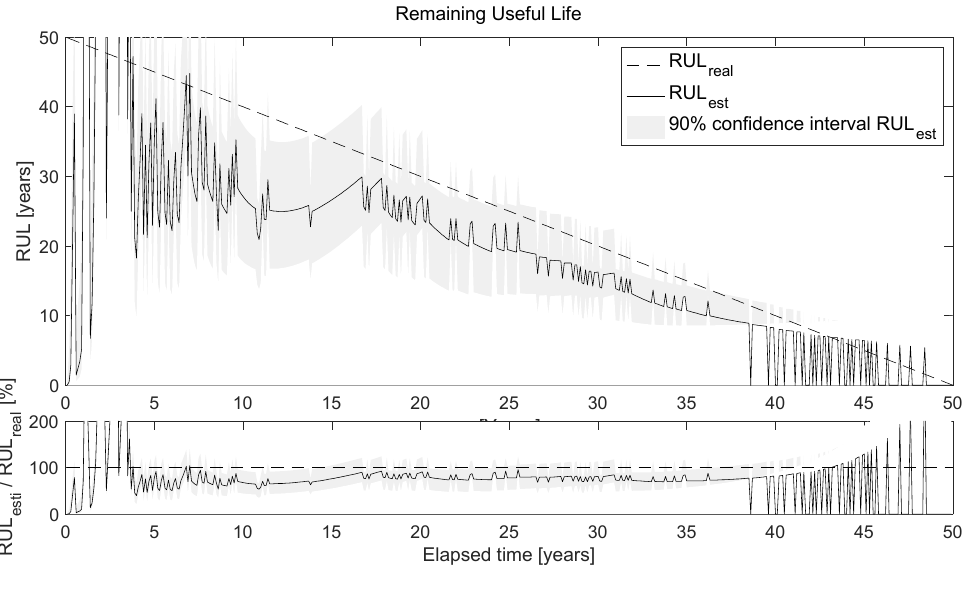
Figure 17. Estimated RUL.